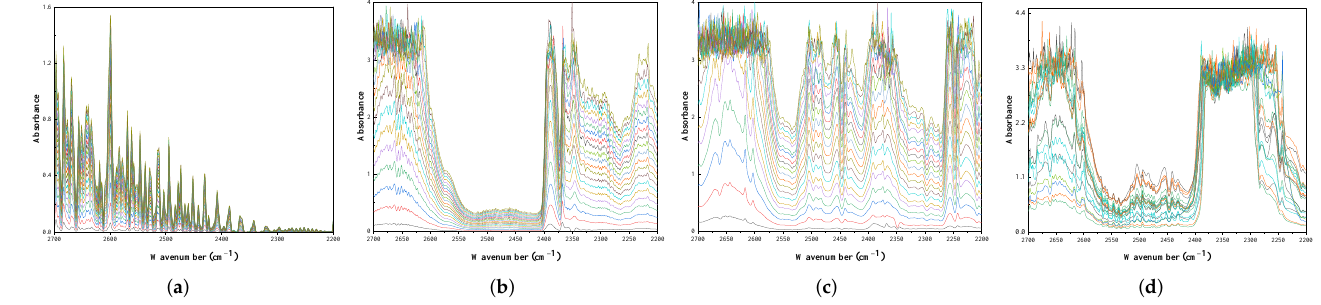
Figure 6. Spectral curve of the sample of the IR spectrum dataset. ( a ) Sample serial number 1 ∼ 20 (C 1 ). ( b ) Sample serial number 21 ∼ 40 (C 2 ). ( c ) Sample serial number 41 ∼ 60 (C 3 ). ( d ) Sample serial number 101 ∼ 120 (mixed dataset).